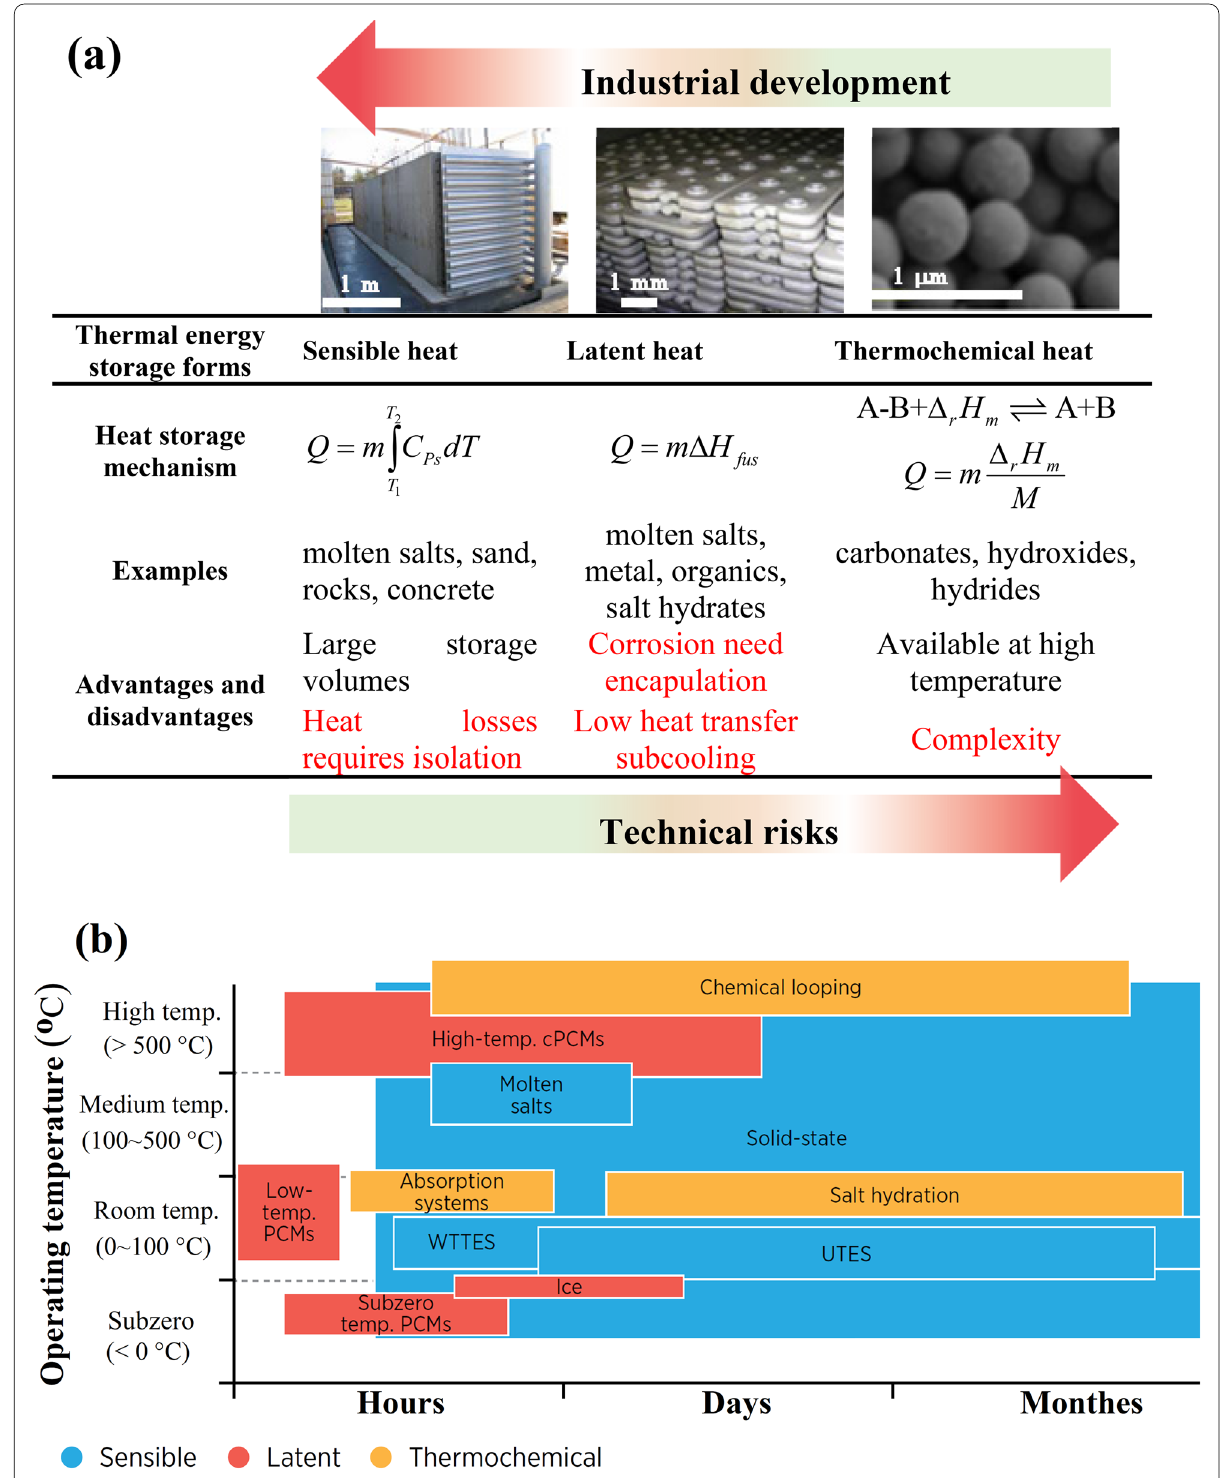
Fig. 9 Schematic representing a brief summary and comparison of three thermal energy storage technologies ( a ) and possible temporal and spatial distribution in operation ( b